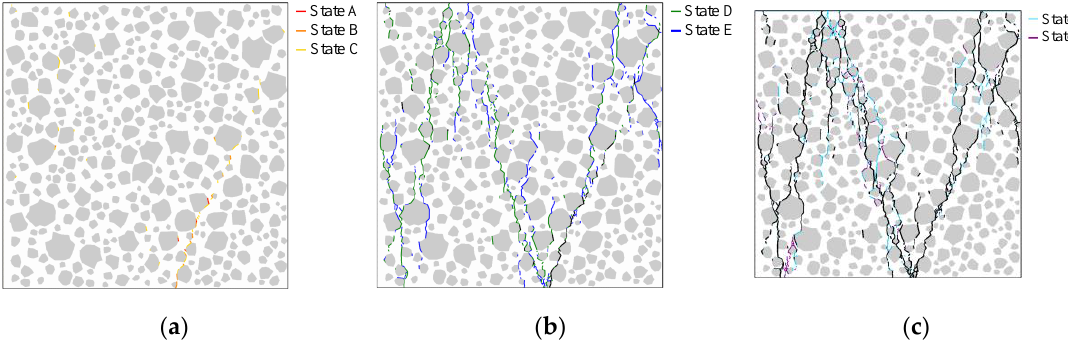
Figure 14. Crack propagation process of a specimen: ( a ) State A, B, C; ( b ) State D, E; ( c ) State F, G.